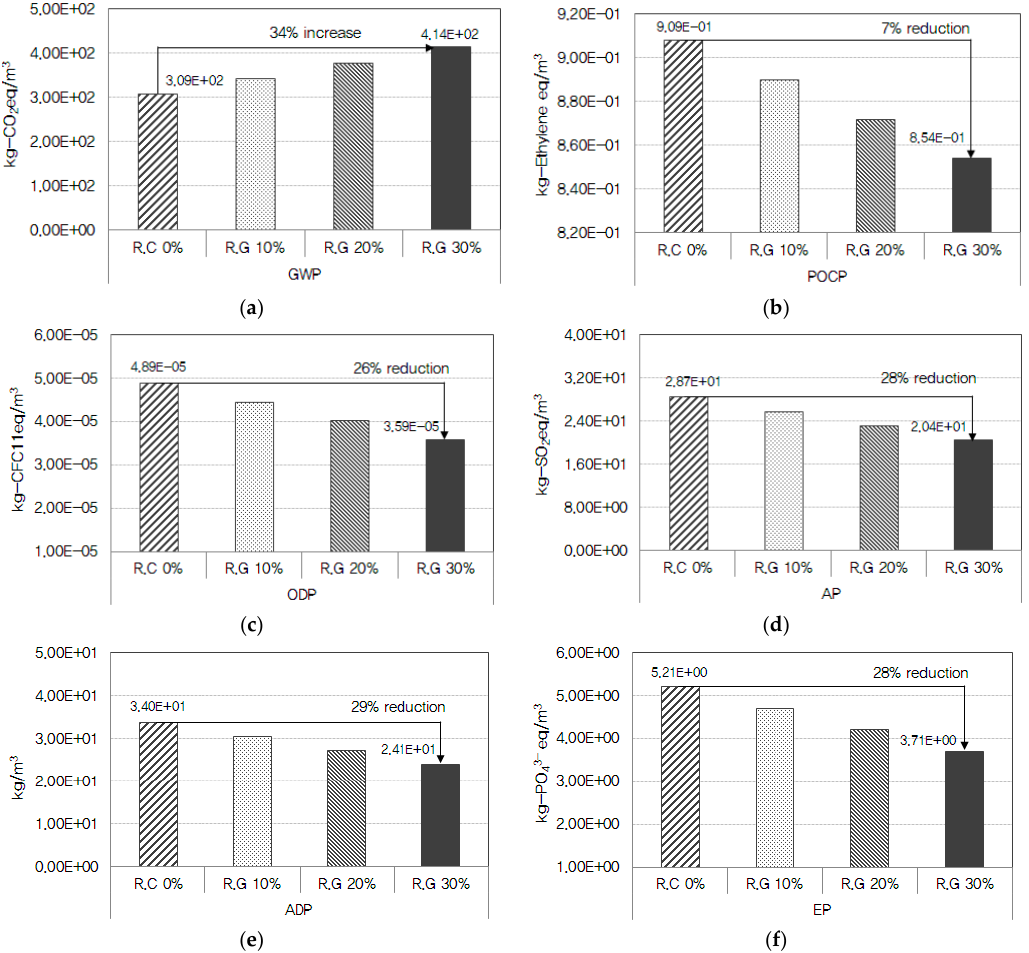
Figure 6. Analysis of environmental impacts according to the mix ratio of recycled aggregate: ( a ) global warming potential (GWP); ( b ) photochemical ozone creation potential (POCP); ( c ) ozone depletion potential (ODP); ( d ) acidification potential (AP); ( e ) abiotic depletion potential (ADP); and ( f ) eutrophication potential (EP).